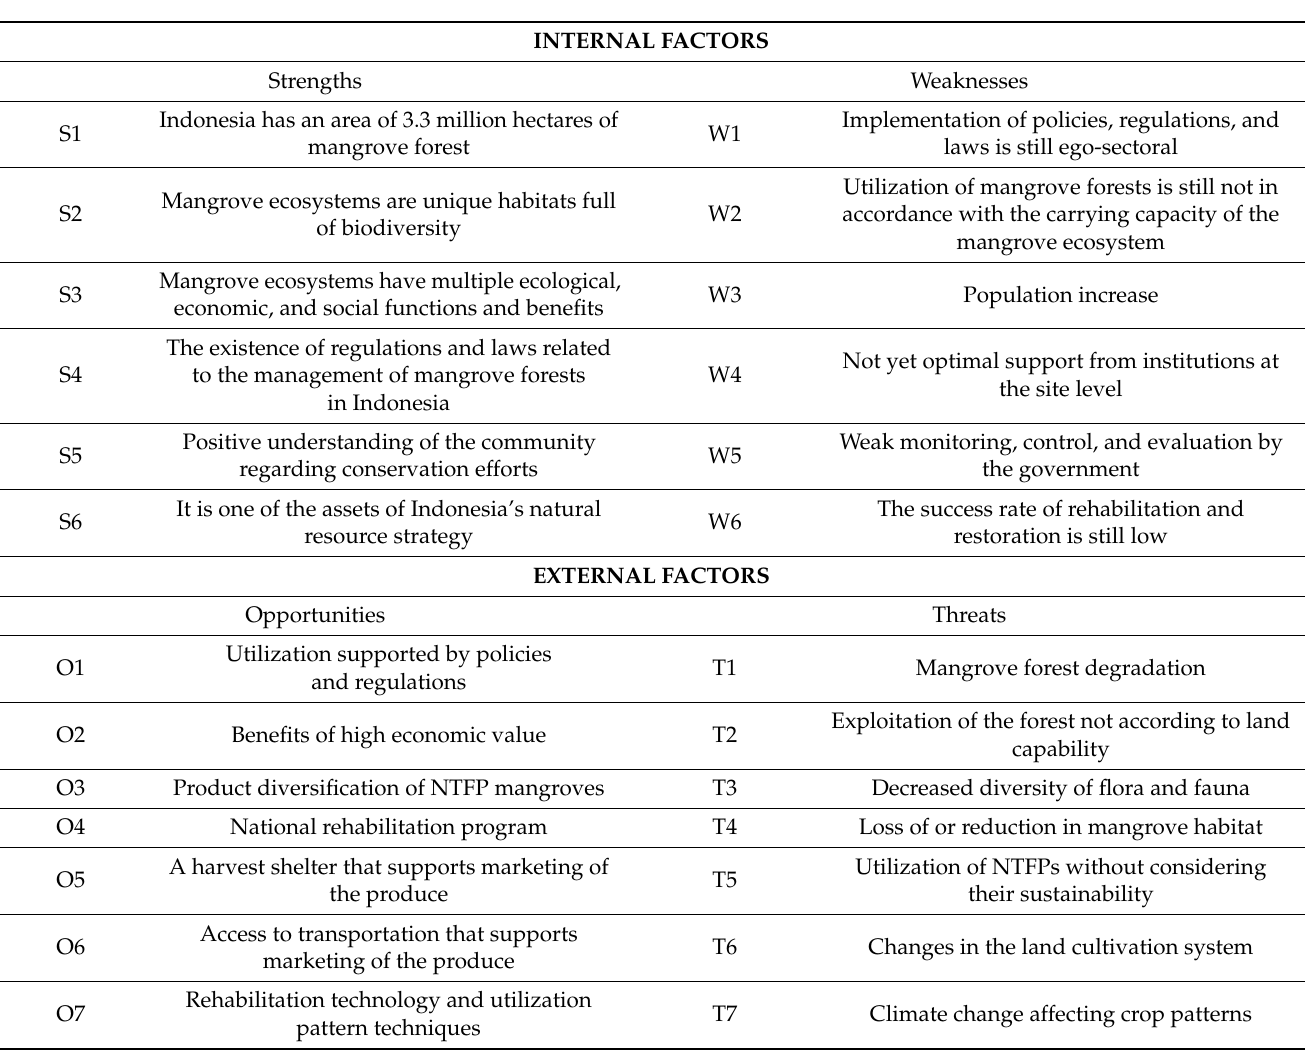
Figure 3. Stages of strategy formulation using SWOT analysis [117]. Table 2. Internal and external factors in SWOT